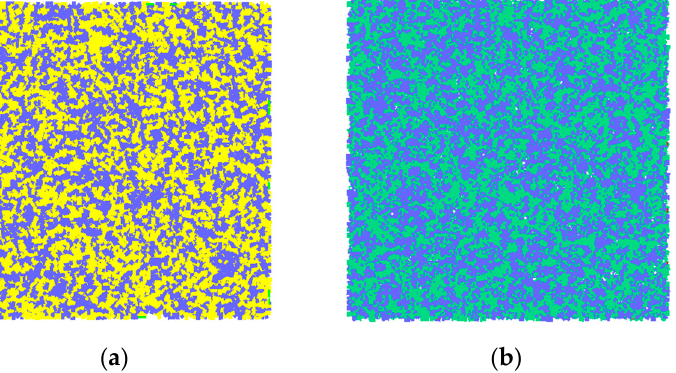
Figure 8. Simulation contact of specimens. ( a ) Ordinary concrete. ( b ) Nano-TiO 2 modified concrete.